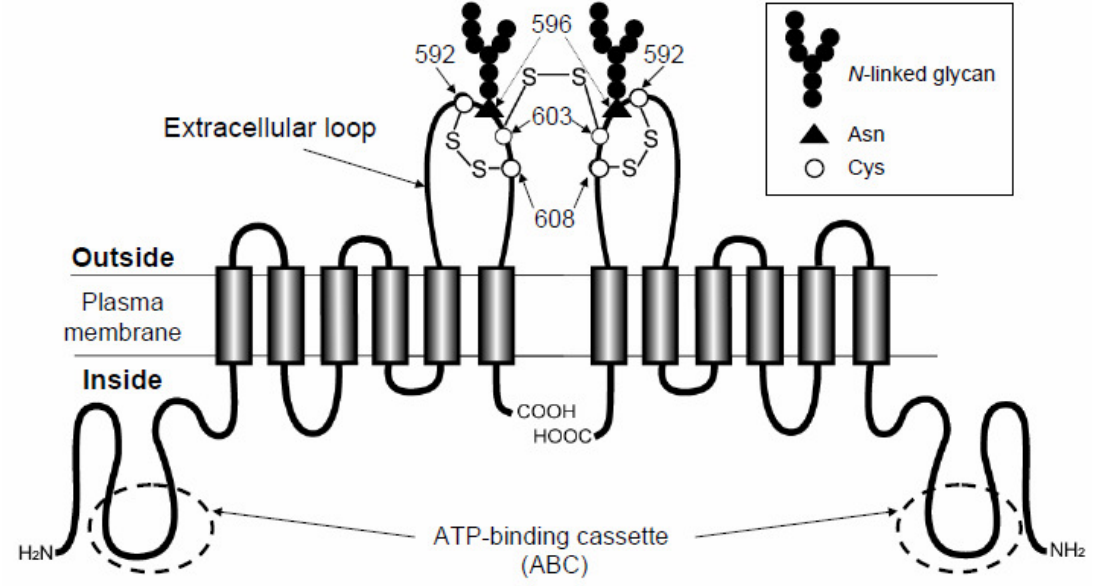
Figure 4. Schematic illustrations of ABCG2 protein structure. The ABCG2 protein expressed in the plasma membrane is a homodimer linked via a cysteinyl disulfide bond. The cysteine residue corresponding to Cys603 of human ABCG2 is involved in homodimer formation. The substrate-binding site is formed when ATP is bound to the ATP-binding cassettes (ABC) of the ABCG2 homodimer. Disulfide bond formation at Cys603 does not appear to be prerequisite for exerting the transport activity of ABCG2.